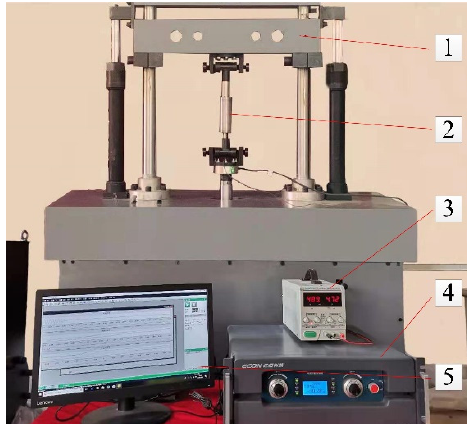
Figure 18. Dynamic performance test rig. (1) Vibration excitation platform, (2) MR damper, (3) DC power, (4) electro-hydraulic servo controller, (5) computer.